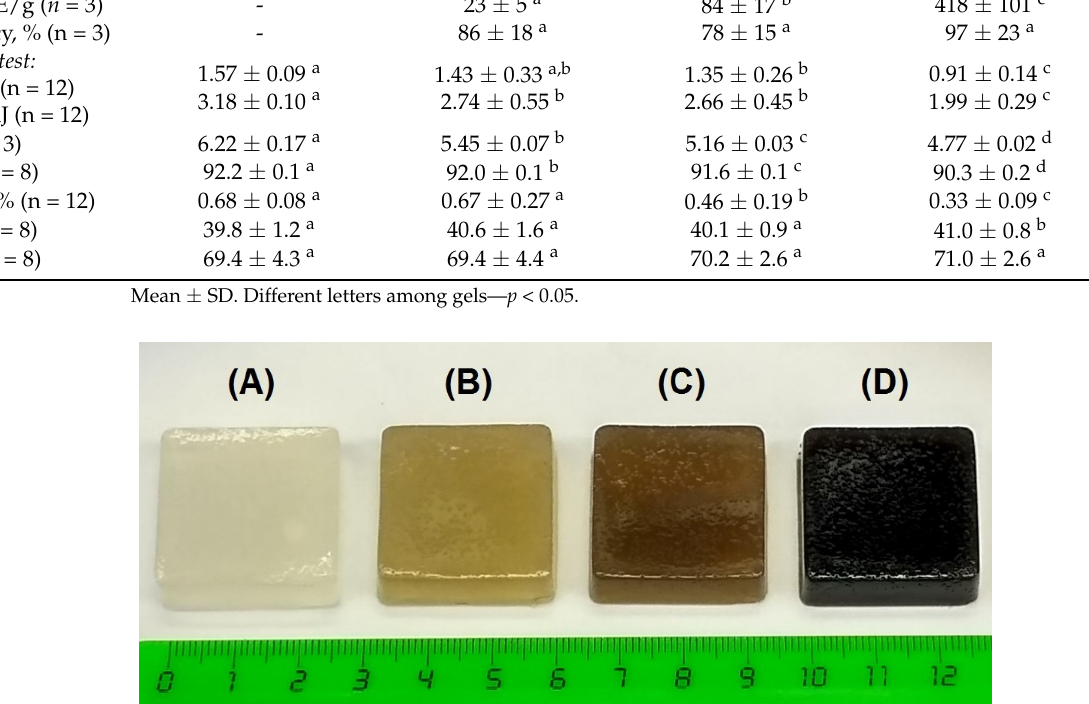
Table 1. Characterization of agar gel (A) and agar gels enriched with fireweed pectin (A-FP). A A-FP0.1